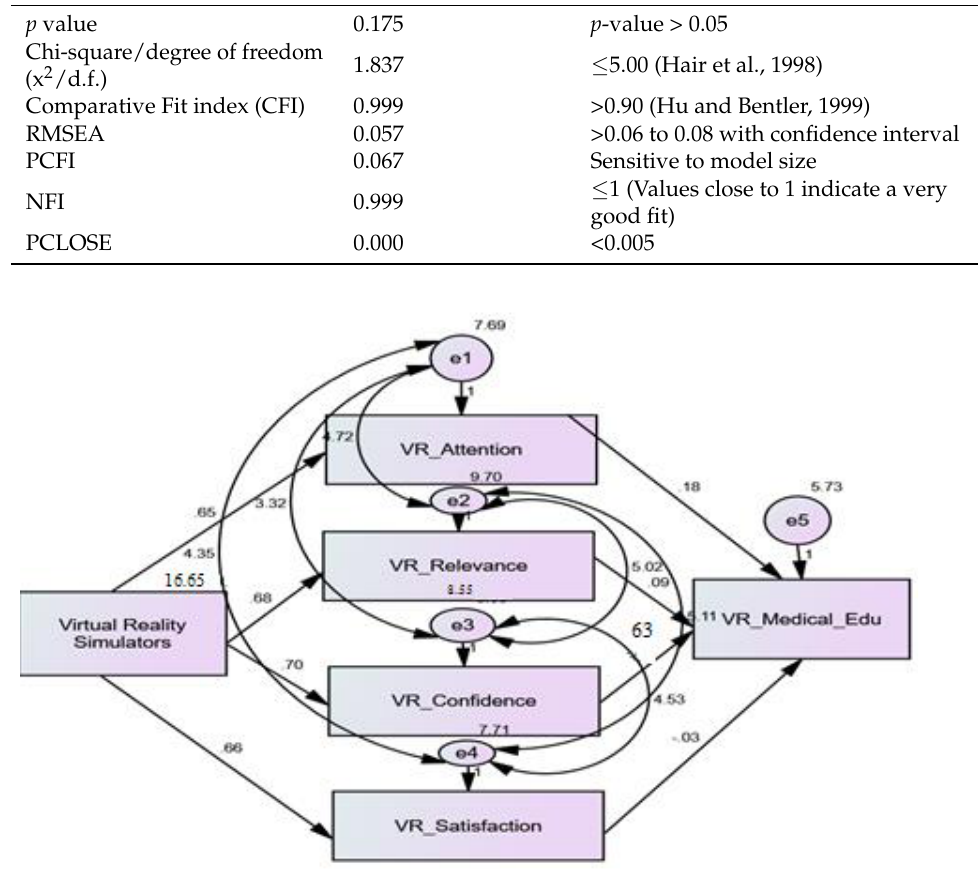
Figure 5. VR based structural model for learning. Table 5. Regression weights: maximum likelihood estimates.